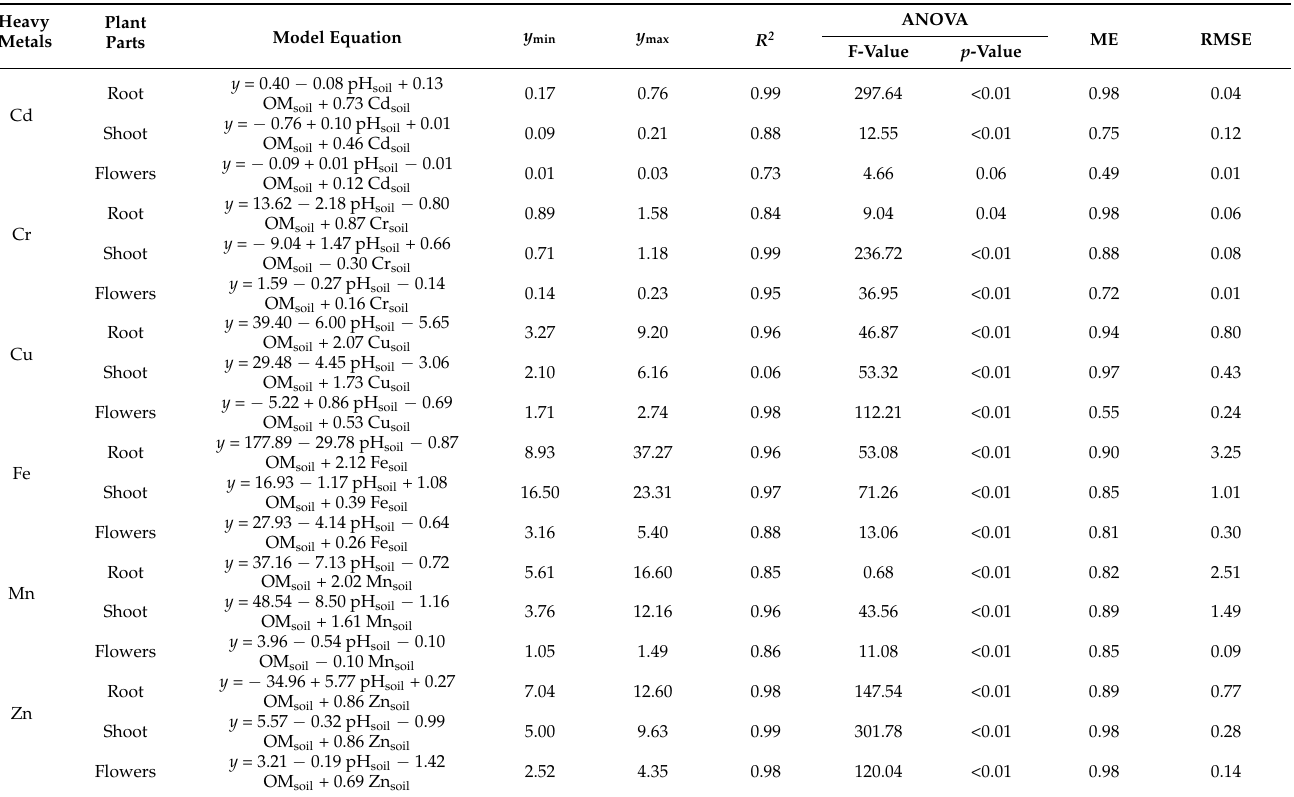
Table 5. Prediction models for uptake of heavy metal by different vegetative parts of marigold cultivated on sewage sludge amended